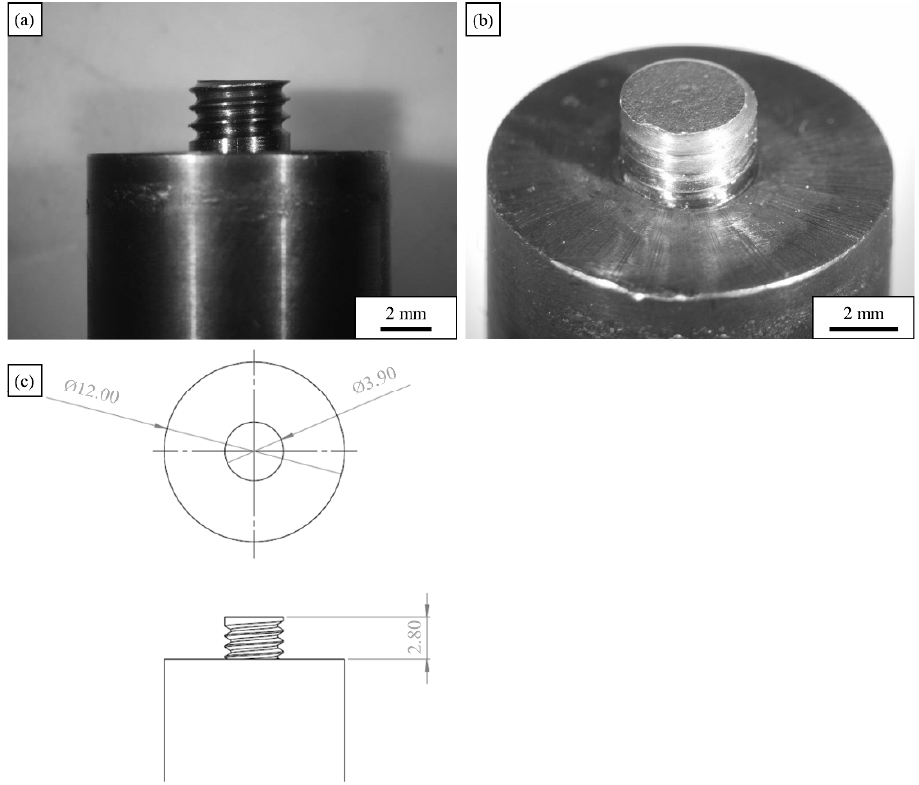
Figure 1. FSW tool. Detail of the ( a ) thread configuration; ( b ) flat shoulder; and ( c ) simple drawing. After welding, metallographic samples were cut from the center of the weld coupons.